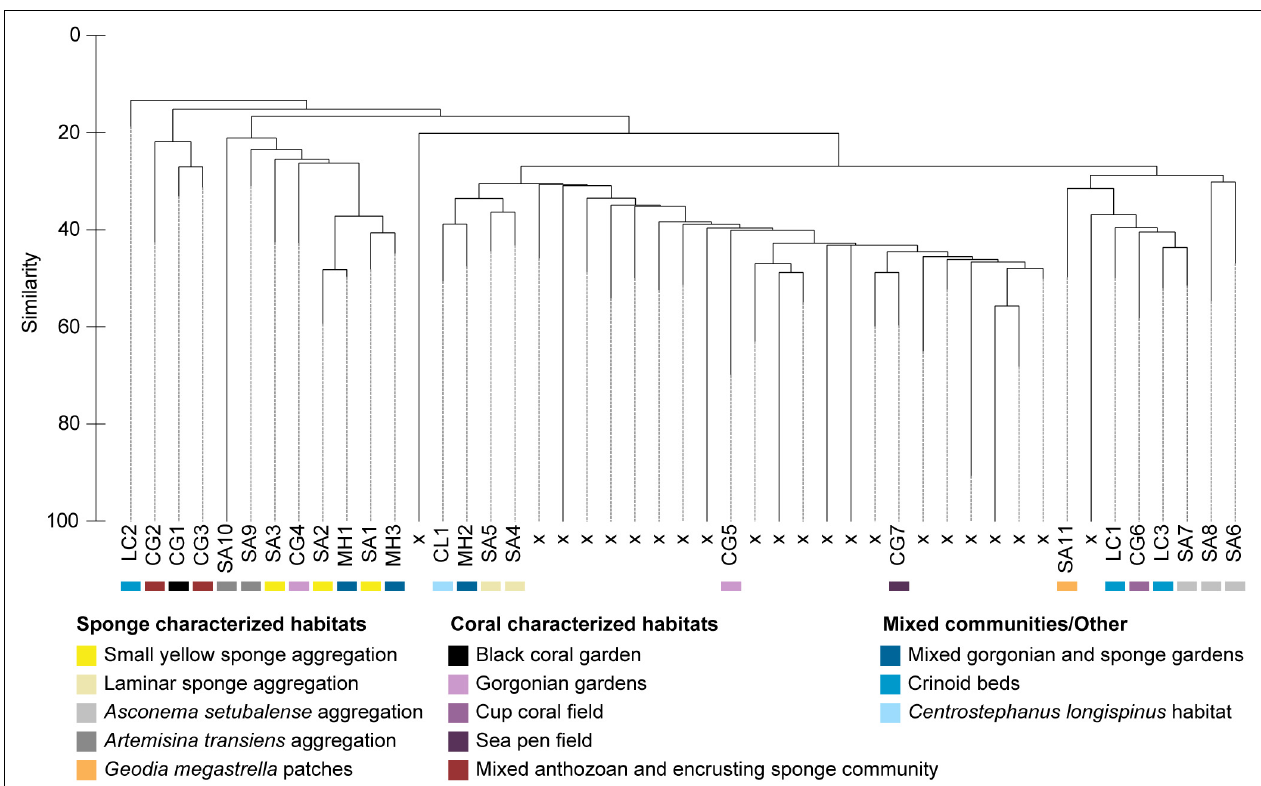
FIGURE 3 | Cluster analysis of the species data with the inclusion of the SIMPROF routine. The 25 assemblages of potential conservation concern resulting from the first two criteria, are indicated with labels and a color code corresponding to the habitat to which they were assigned. Excluded assemblages are labeled “x” and were rejected based on failing criteria (i) and (ii) (dashed lines) or not resulting in significant assemblages according to SIMPROF (solid